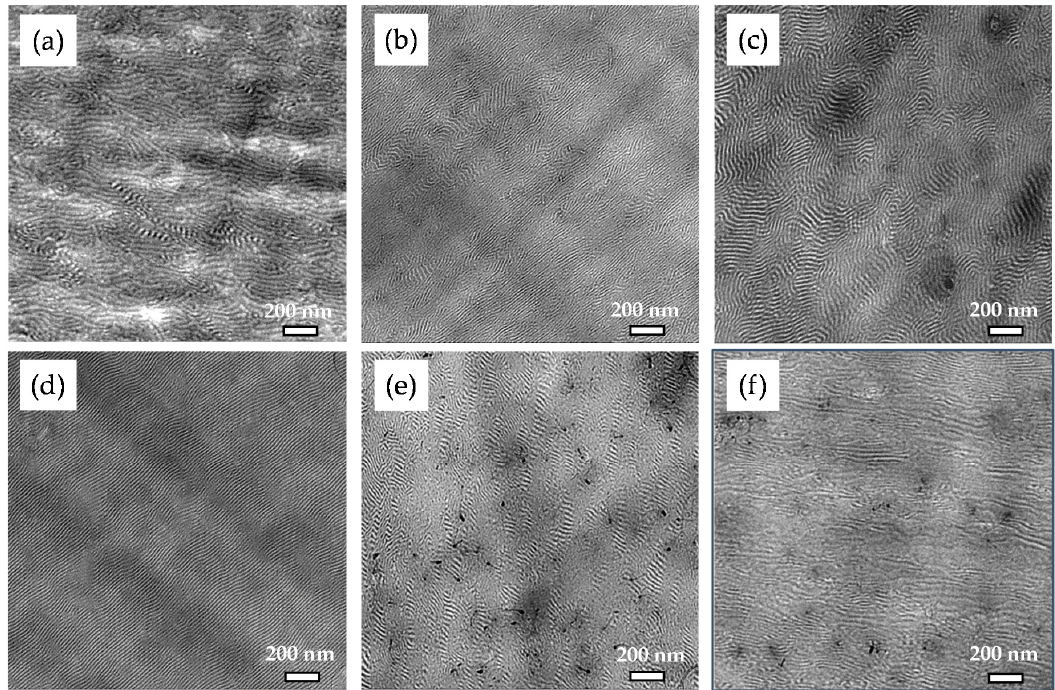
Figure 5. Morphology images from TEM of ( a ) LN3_D, ( b ) LN3_0.1_D, ( c ) LN3_0.3_D, ( d ) LN3_0.5_D,